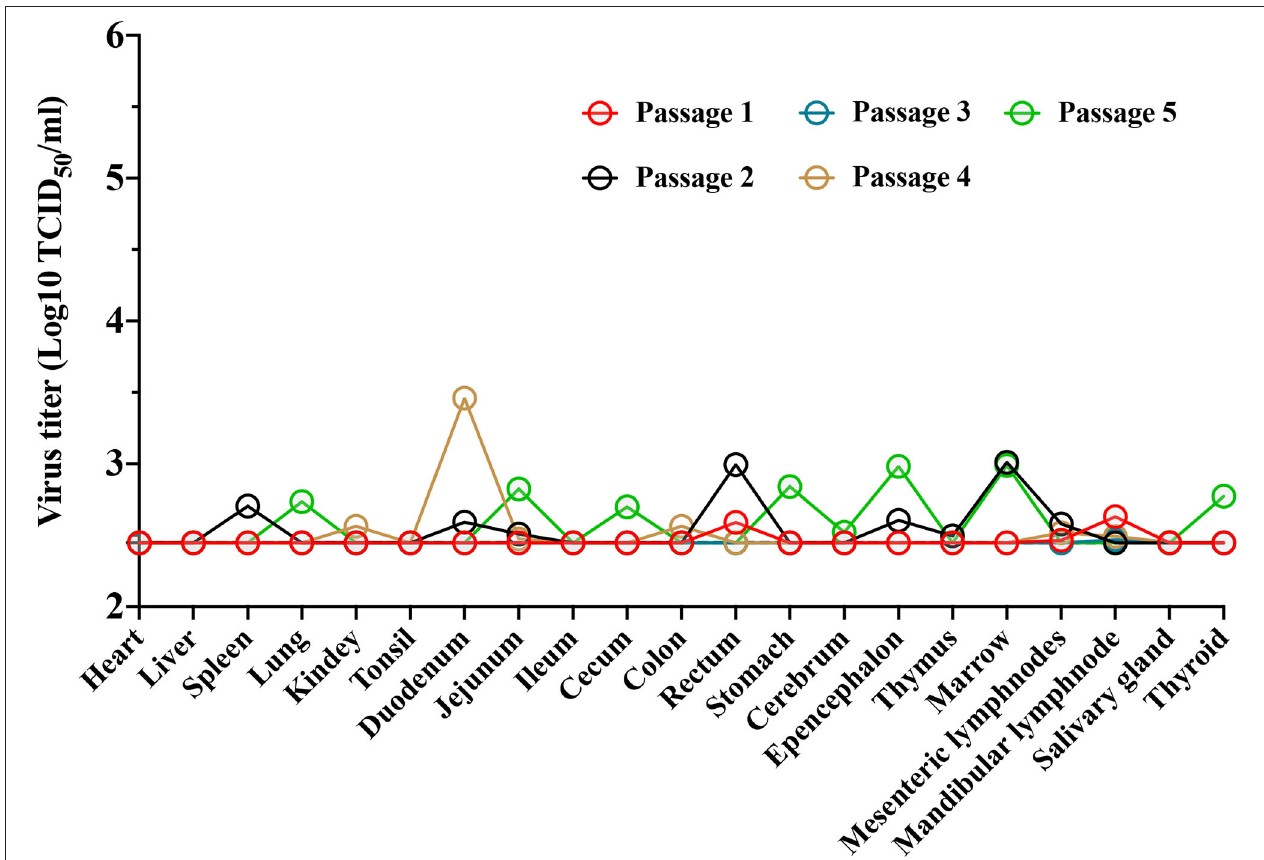
FIGURE 4 | Virulence of the ASFV- 1 ECM3 virus by serial passages in pigs. The ASFV- 1 ECM virus was serially passaged in pigs five times, the organs and tissues with lesions were collected, dissociated, and re-injected into pigs. The qPCR analysis for detection of the viral distribution in pigs. The sensitivity of virus detection was ≥ 10 2.45 TCID 50